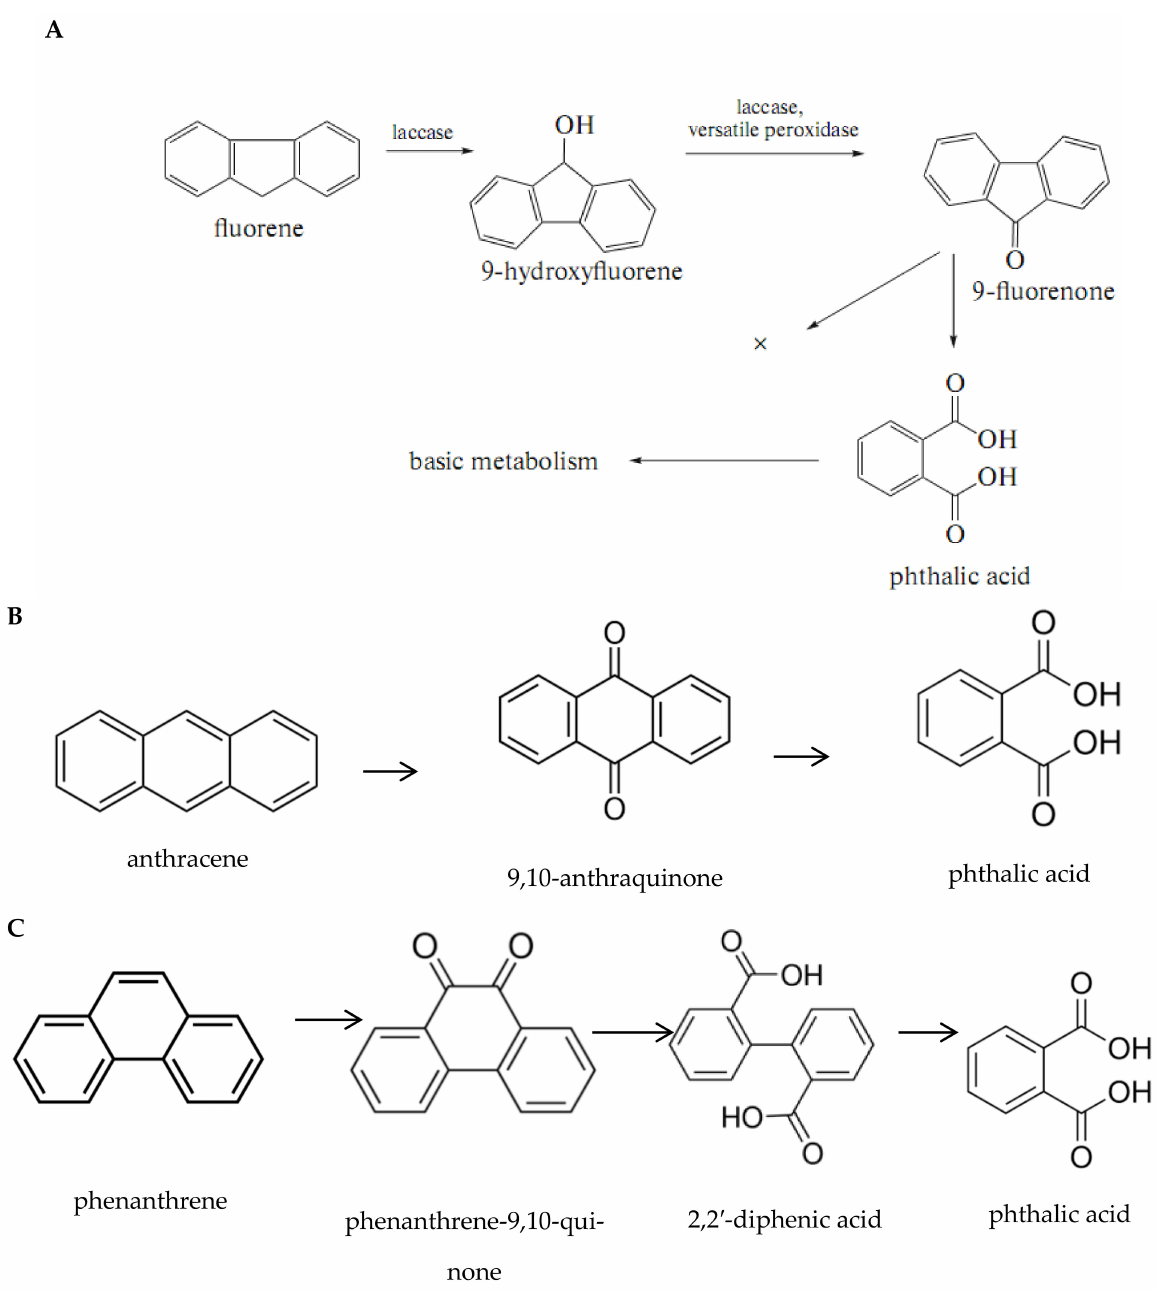
Figure 1. The proposed metabolic pathways of fluorene ( A ), anthracene ( B ), and phenanthrene ( C )